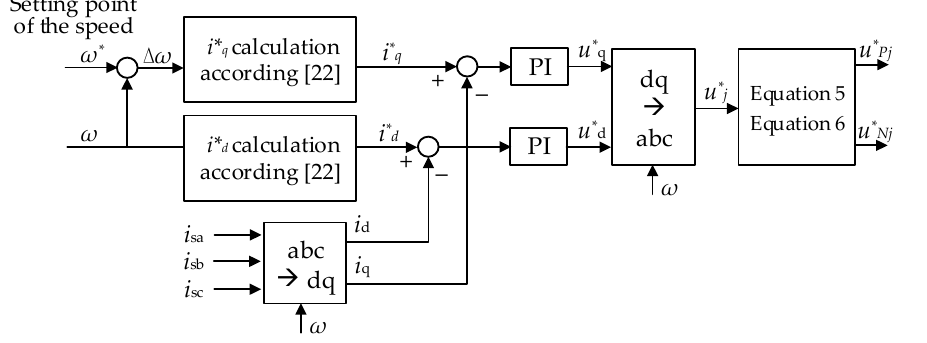
Figure 4. Block diagram of variable frequency speed control.